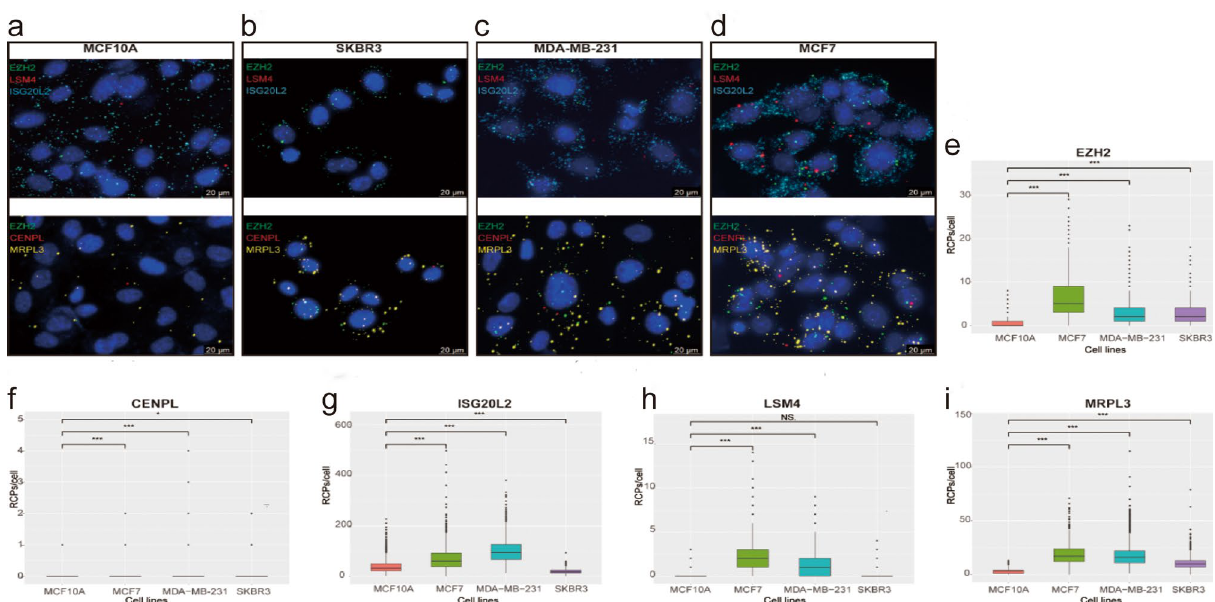
Figure 8. RNA in situ detection of five hub genes in different cell lines. ( a–d) Demonstration of the expression abundance and spatial localization for each mRNA imaging in single cells. ( a) five hub genes detection in MCF10A cell; ( b) five hub genes detection in MDA-MB-231 cell; ( c) five hub genes detection in MCF7 cell; ( d) five hub genes detection in SKBR3 cell. ( e–i) Distribution of RCPs/cell of each probe in four cell lines (MCF10A, MCF7, MDA-MB-231 and SKBR3). NS. Denotes P ˃ 0.05; * denotes P < 0.05; *** denotes P <